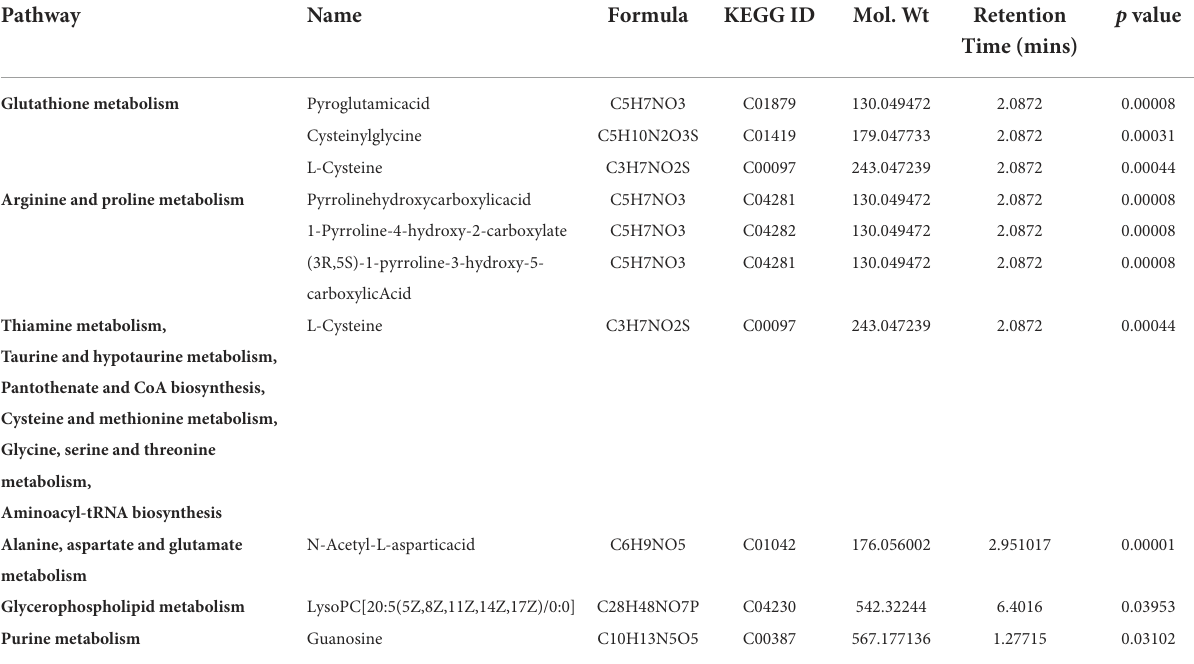
Initial untargeted UPLC-MS/MS